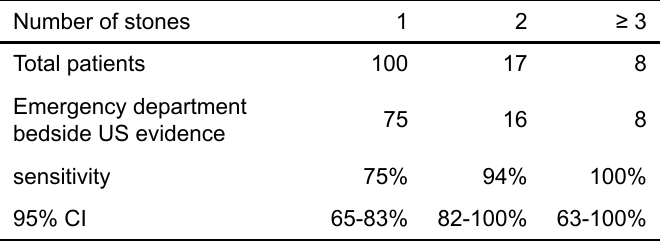
Table 4. Sensitivity of ultrasound (US) by stone number.